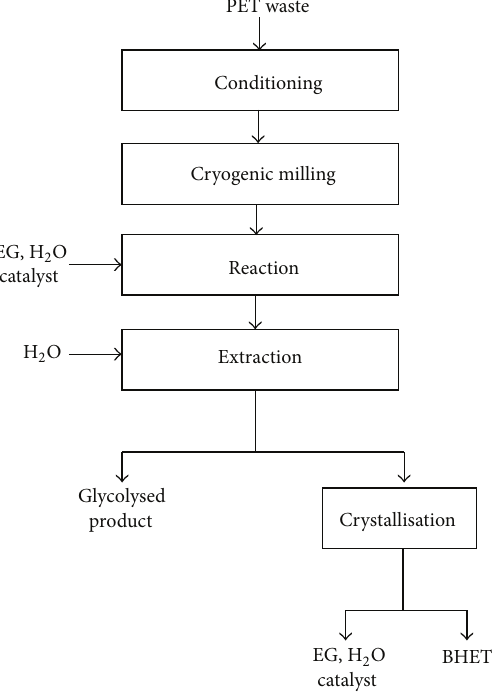
Scheme 1: Schematic diagram of the reaction and analytical proce- dure for the glycolysis of PET